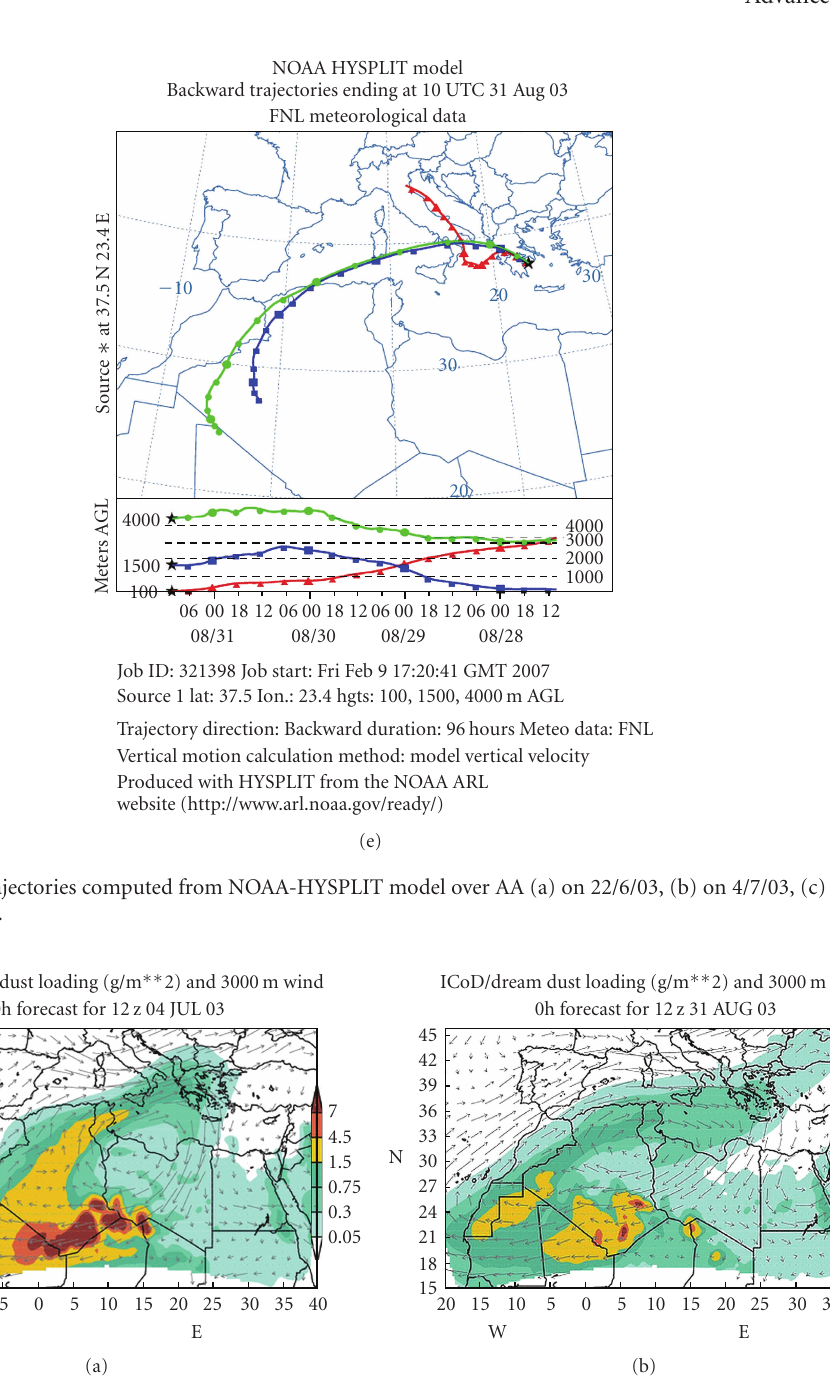
AOD 550 was 0.195 and 0.175, respectively. As